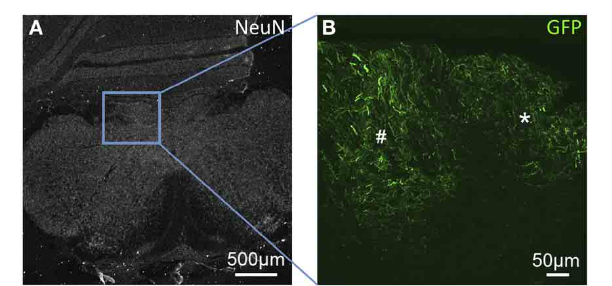
FIGURE 1 | GFP-ir fibers in somatosensory nuclei of the medulla. (A) Low-magnification image showing the pattern of NeuN-ir in this tissue section (approximately − 7.3mm Bregma). (B) GFP-ir in the gracile ( ∗ ) and cuneate (#)